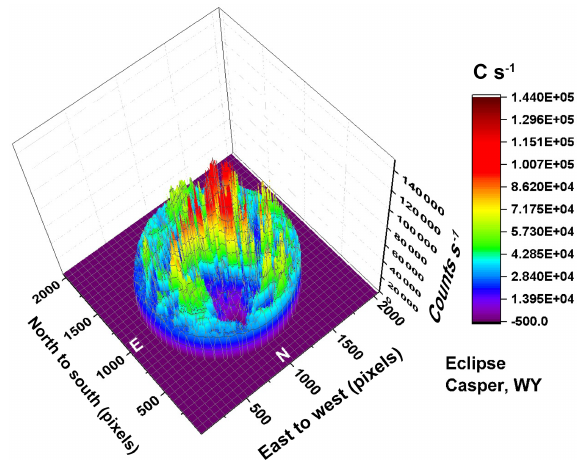
Figure 7. The counts per second observed by EPIC for the 443nm channel corresponding to the color image shown in Fig. 1. In the data file, the word infinity has been replaced by the number zero. In this image there are approximately Np = 2 . 59 × 10 6 illuminated pixels out of 2048 2 = 4 . 194304 × 10 6 pixels (61.8%).